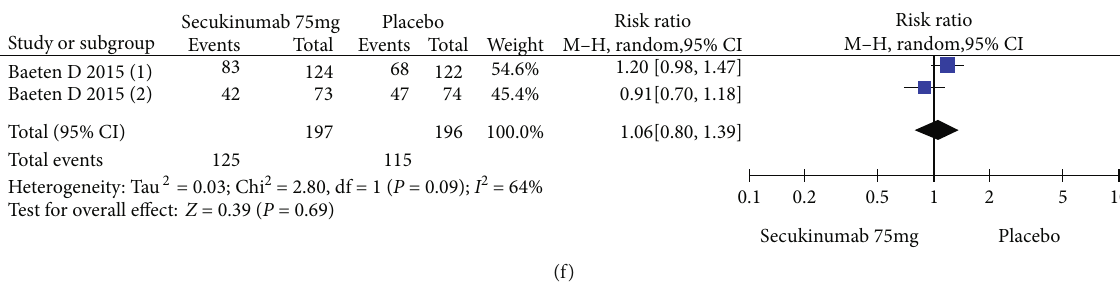
Figure 4: Meta-analysis of secukinumab 75 mg versus placebo at week 16. (a) ASAS 20 response, (b) ASAS 40 response, (c) ASAS 5/6 response, (d) SF-36 PCS score (change from baseline), (e) ASQoL score (change from baseline), (f) AEs. Baeten 2015 (1): MEASURE 1 study, Baeten 2015 (2): MEASURE 2 0 : 37 ) (Figure 5), showing no signi fi cant di ff erence between the two groups.